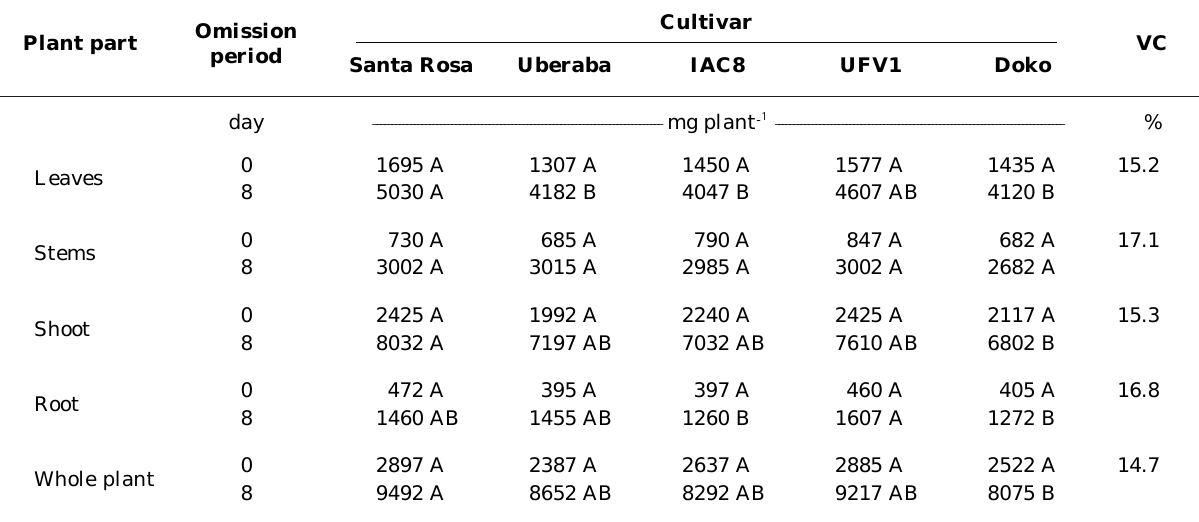
Table 3. Dry matter production by leaves, stems, shoots, roots, and whole plant of five soybean cultivars cultivated for 31 days in complete nutrient solution or submitted to 8 days of phosphorus